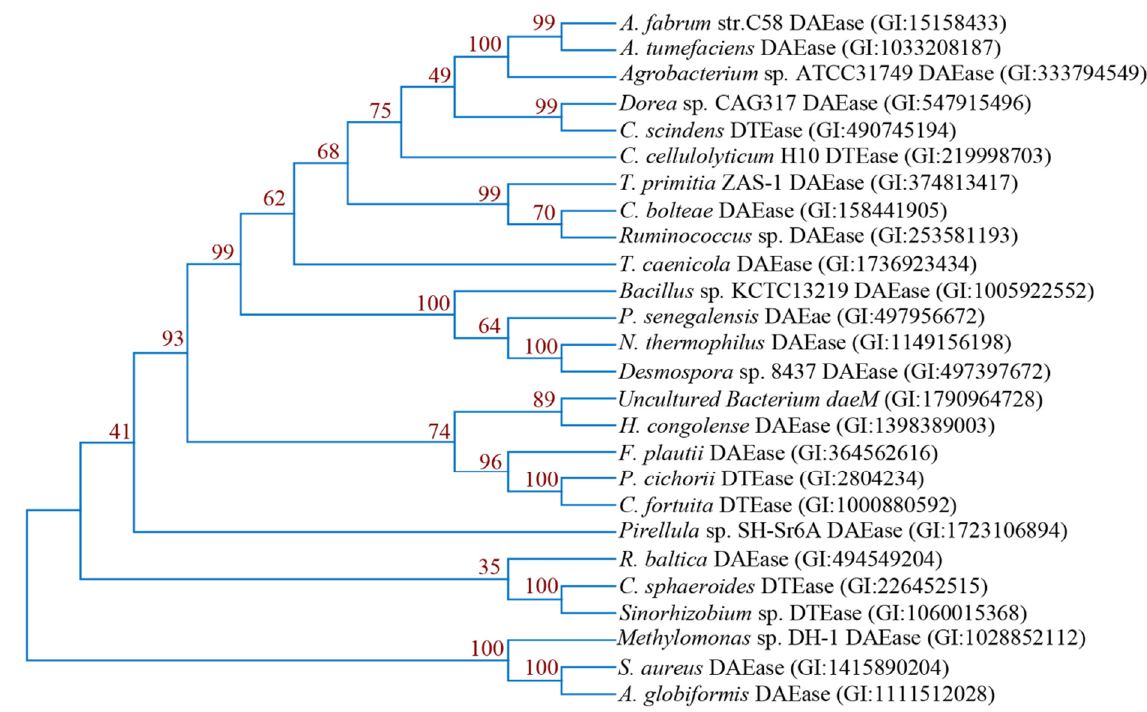
Figure 4. Phylogenetic tree of D -allulose-3 epimerases generated based on the amino acid sequences, using the MEGA X program with the neighbor-joining method.